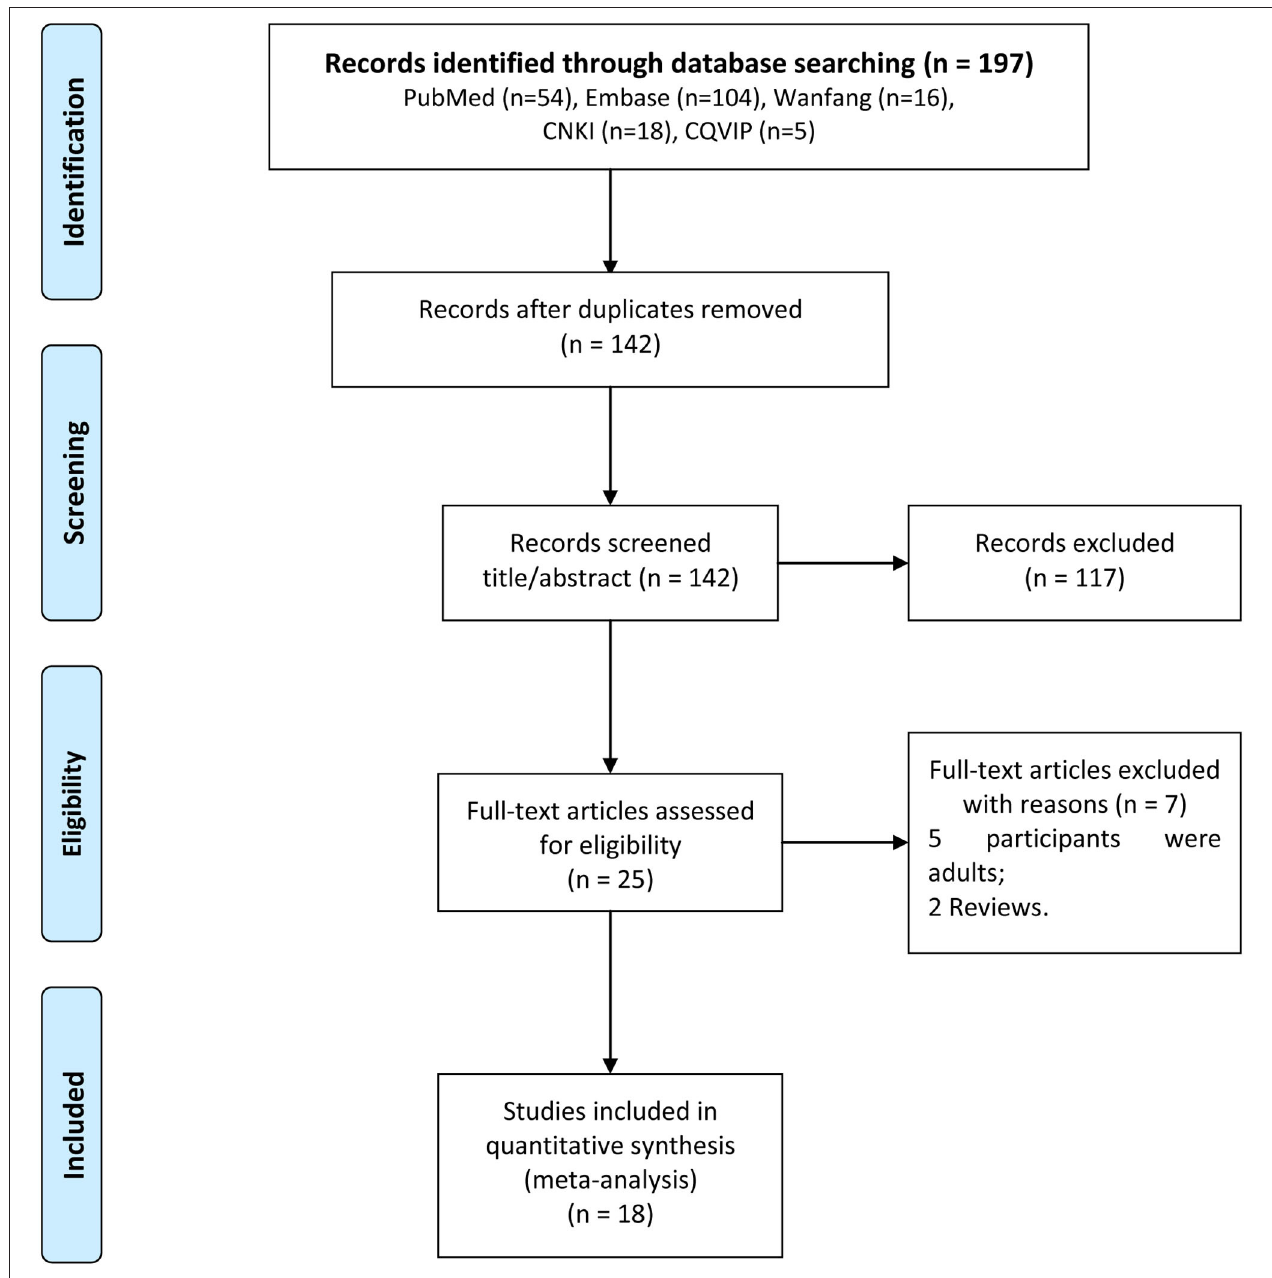
FIGURE 1 | The detailed flow chart for study